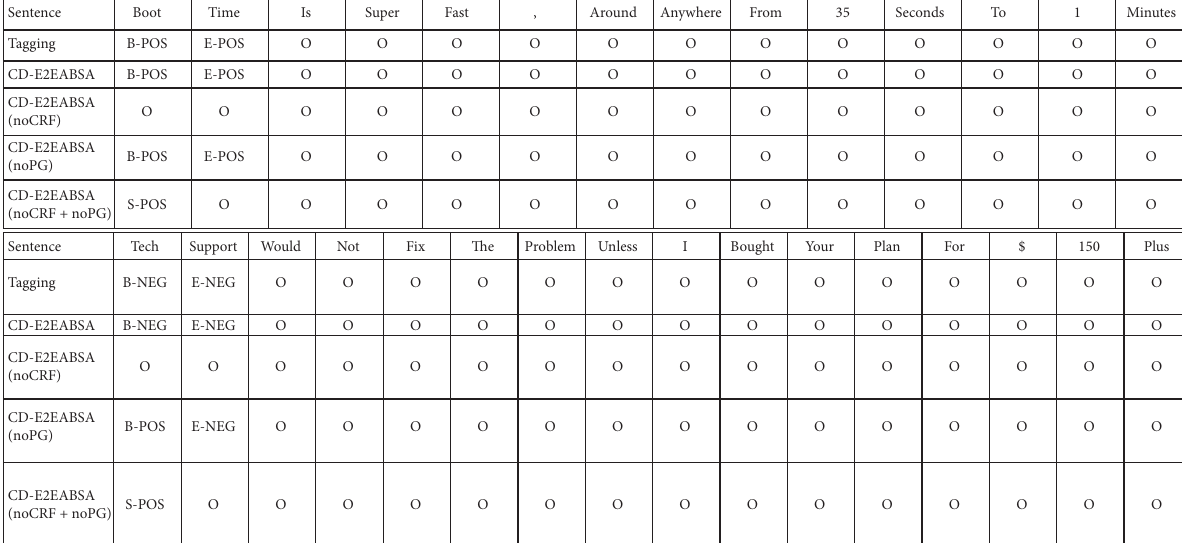
Figure 4: Tagging examples output by different